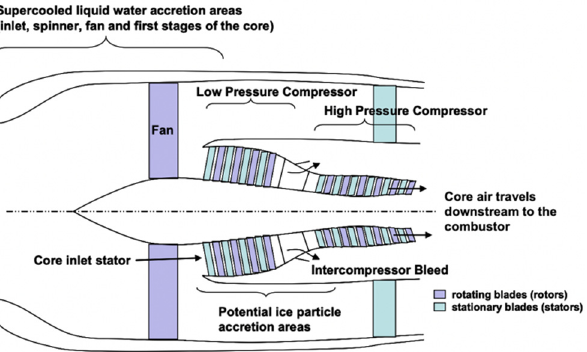
Figure 5. Structure of the engine and potential ice accretion area (reproduced from [7]).